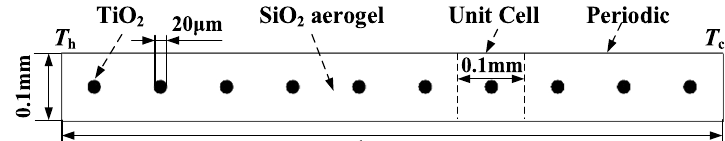
Fig. 4 Computational domain for Example